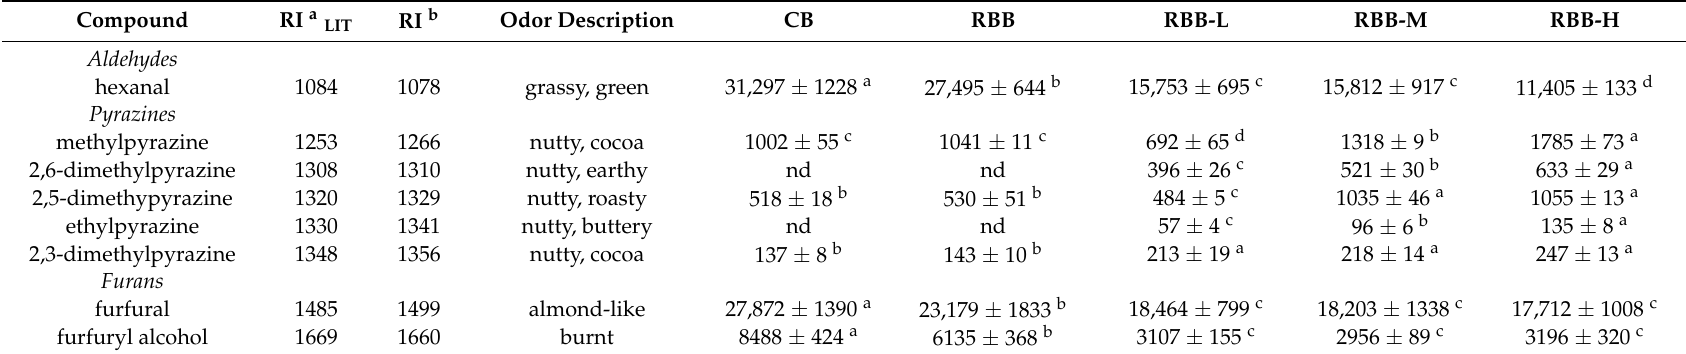
Table 3. Volatile compounds identified in control biscuits (CB), rye-buckwheat biscuits (RBB) and in biscuits with increasing rutin addition (RBB-L, RBB-M, RBB-H, respectively). The compounds were identified by comparing its mass spectrum and RI with standard compounds. Results are expressed as ng g − 1